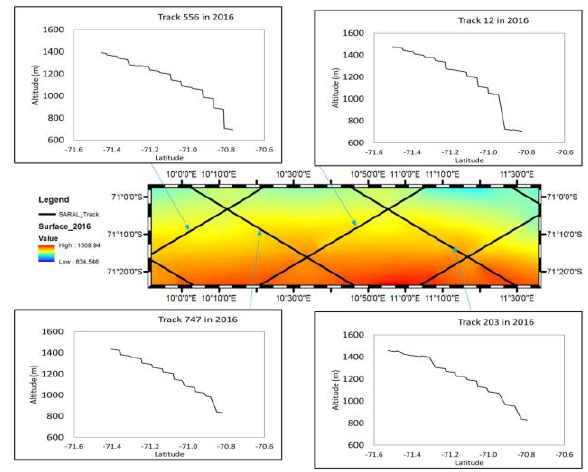
Figure 12. Ice Sheet Elevation profile for January 2016